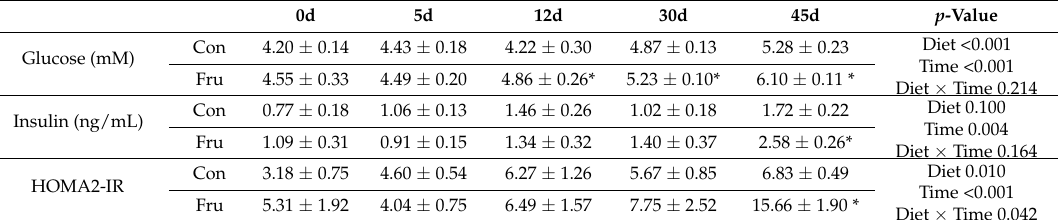
Figure 1. Plasma branched-chain amino acids (BCAA) levels ( µ M) at the fasting (overnight) and fed (2 h after the last meal) in rats fed a control or high-fructose diet for 45 days. Data is presented as mean ± SEM ( n = 8). * represent significant ( p < 0.05) differences between groups at a given time. Table 1. Fasting plasma glucose and insulin levels and HOMA2-IR (homeostasis model assessment-estimated insulin resistance) index of rats fed on a control or high-fructose diet for 45 days. Data is presented as mean ± SEM ( n = 8). Data was analyzed using two-way ANOVA test. *, significantly different from the control condition at a given